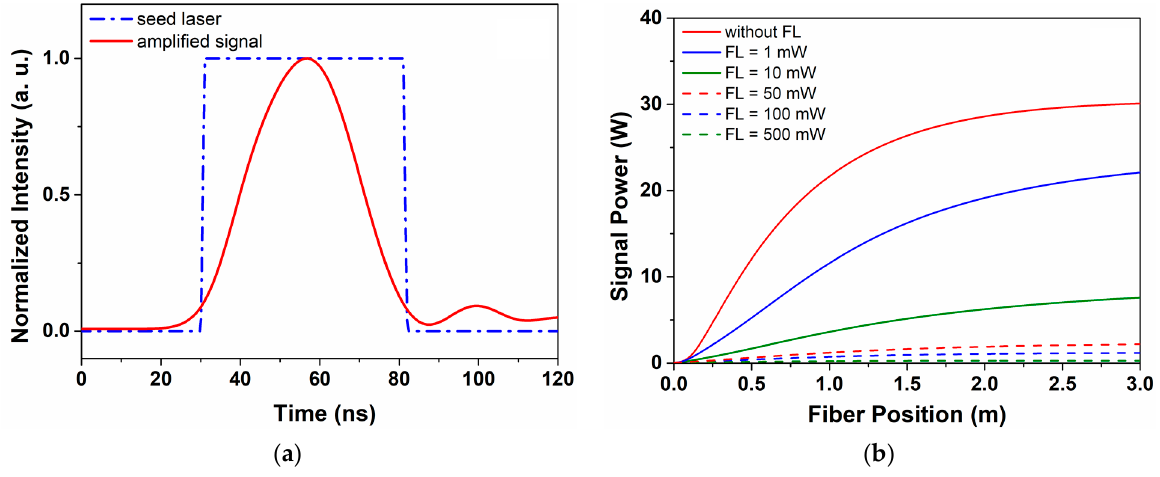
Figure 2. ( a ) The waveform of the seed and the ampli fi ed signal. ( b ) The average power evolution with varying FL